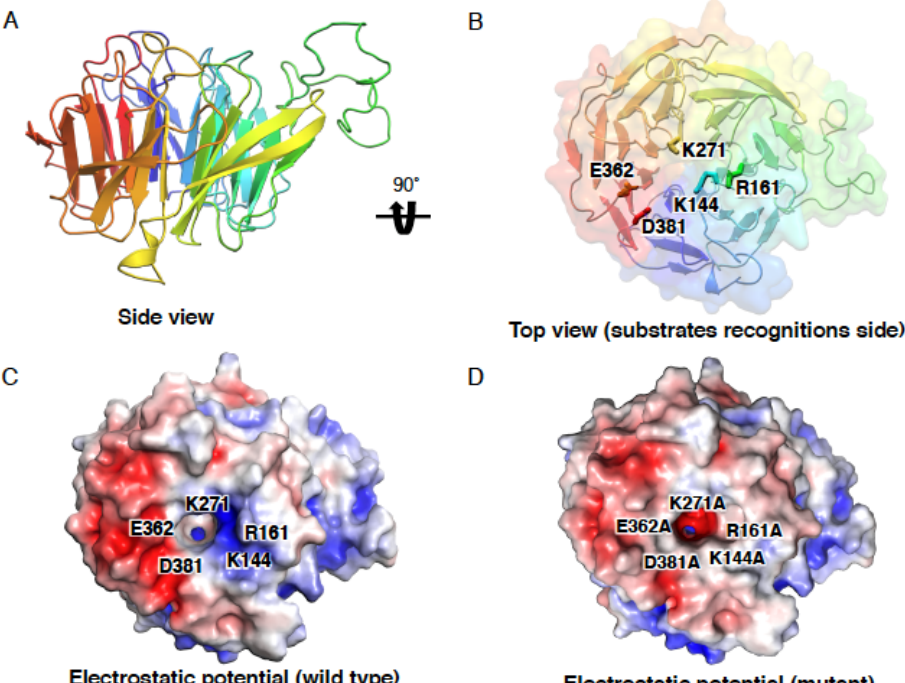
Figure 2. Predicted N-terminal structure of Cdt2 (residues 45–400). ( A ) Highly repetitive residue 45–400, modeled using SWISS MODEL (PDB ID: 2YMU). ( B ) Top view of the β -propeller structure. Hotspot residues that may be involved in substrate recognition are shown. ( C ) Electrostatic potential of the wild-type β -propeller structure illustrated in ( B ). ( D ) Electrostatic potential of the β -propeller structure containing five mutations. The surface electrostatic potential was found to be highly altered by these mutations, especially at residue K271 in the binding cavity.